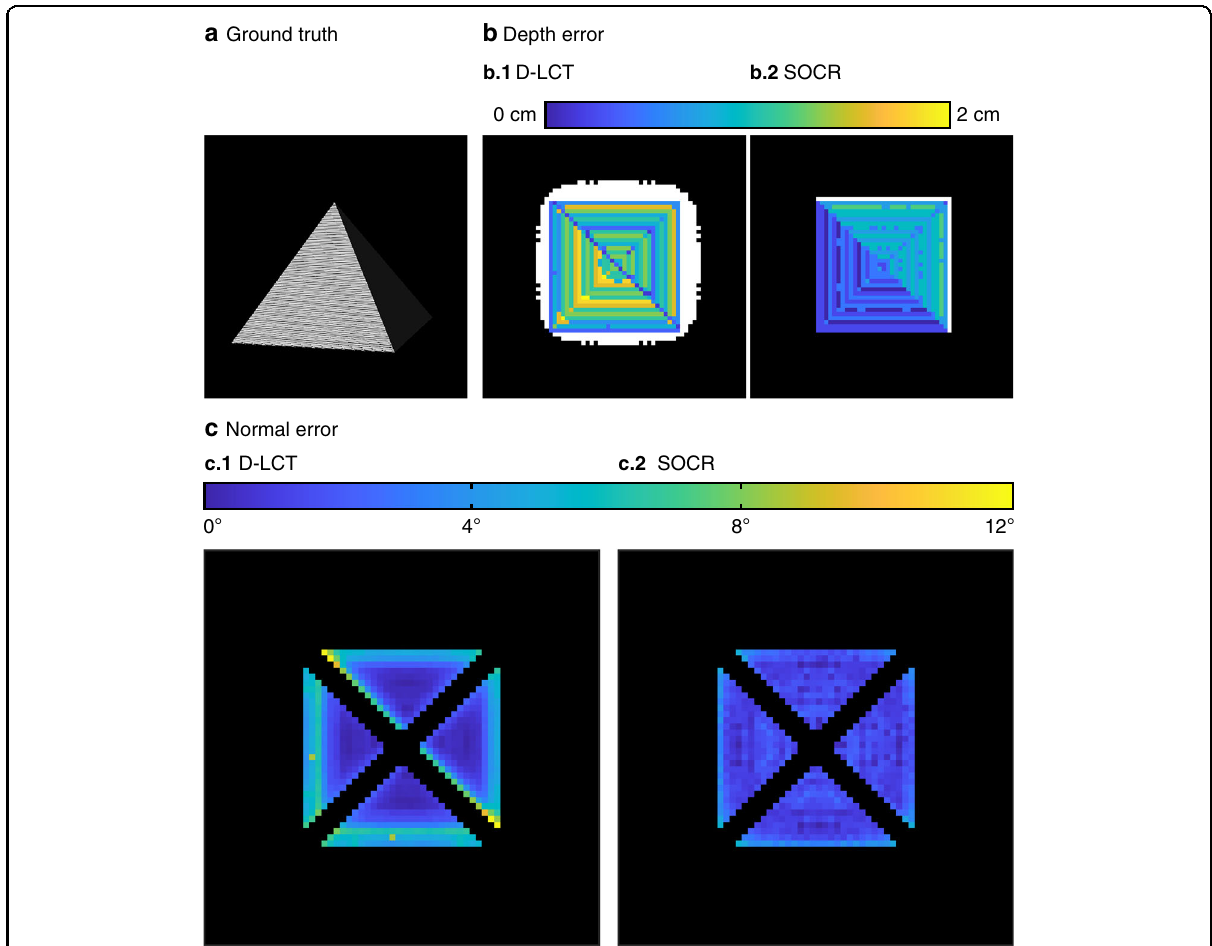
Fig. 6 Absolute depth error and normal error of the pyramid (confocal). The ground truth is shown in a . Absolute depth error of the D-LCT and SOCR reconstructions is compared in b . Normal error of the D-LCT and SOCR reconstructions is shown in c . The depth error is shown in the same way as in Fig. 5, and the normal error is de fi ned as the angle between the normal of the reconstruction and the ground